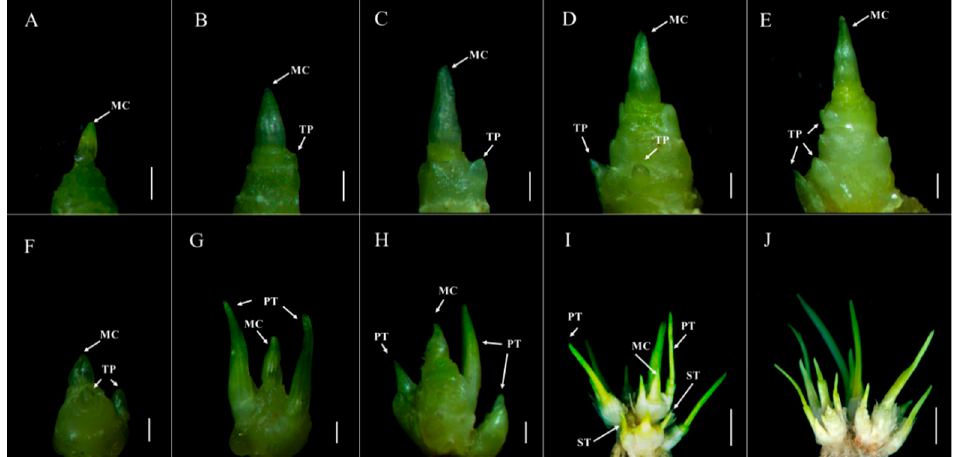
Figure 1. The tiller micromorphology of dwarf-monoculm wheat mutant ( dmc) ( A – E ) and WT ( F – J ). A, B, C, D, E: dmc at the two-leaf stage, three-leaf stage, four-leaf stage, over-winter stage, and between the rising and jointing stage. F, G, H, I: WT at the two-leaf stage, three-leaf stage, four-leaf stage, and over-winter stage. J: some tillers of WT at between the rising and jointing stage. MC: main culm; TP: tiller primordium; PT: primary tiller; ST: secondary tiller. A-H, scale bar = 1 mm; I and J, scale bar = 1 cm.